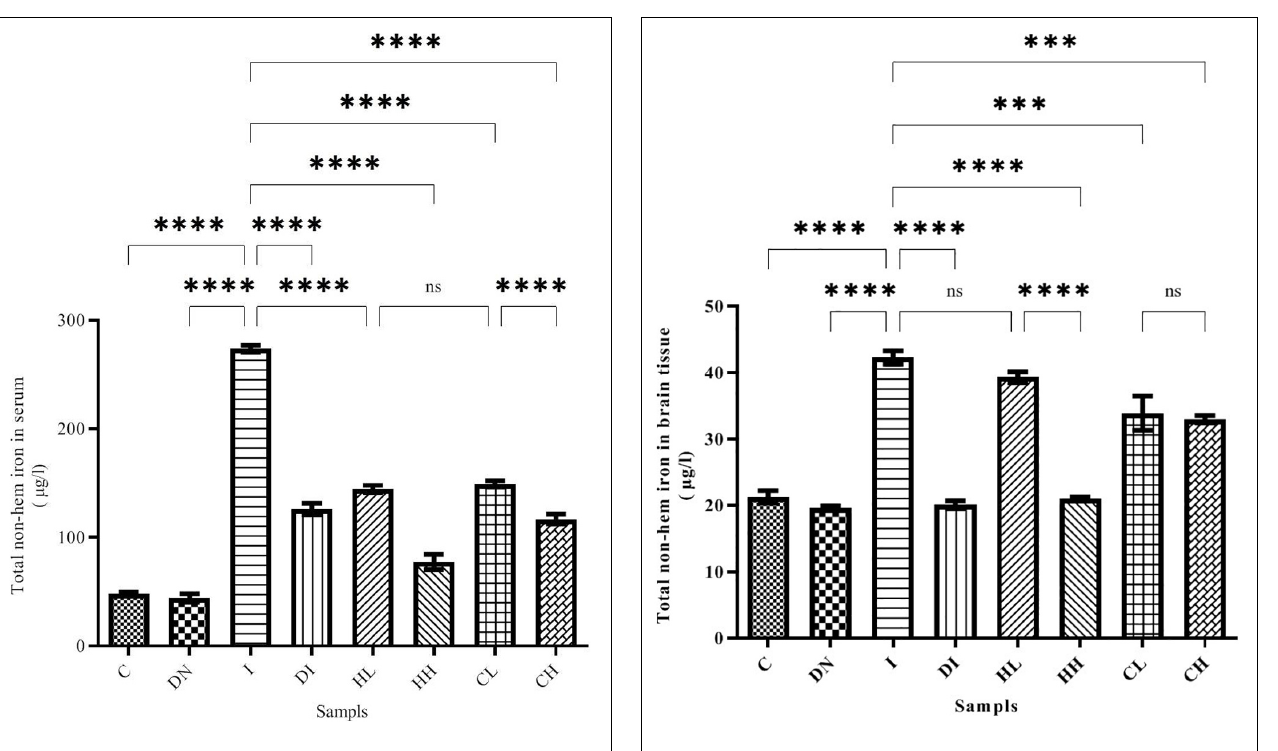
FIGURE 1 | Serum non-heme iron content in the treated mice, Group C, control group: Normal saline-receiving group; Group DN, normal saline and deferoxamine-receiving group; Group I, iron dextran and normal saline-receiving group; Group DI, iron dextran and deferoxamine-receiving group; Group HL, low dose hesperidin-receiving group; Group HH, high dose hesperidin-receiving group; Group CL, low dose coumarin-receiving group; and Group CH, high dose coumarin-receiving group (Mean ± SD; ∗∗∗∗ p ≤ 0.0001, ns: non-significant).